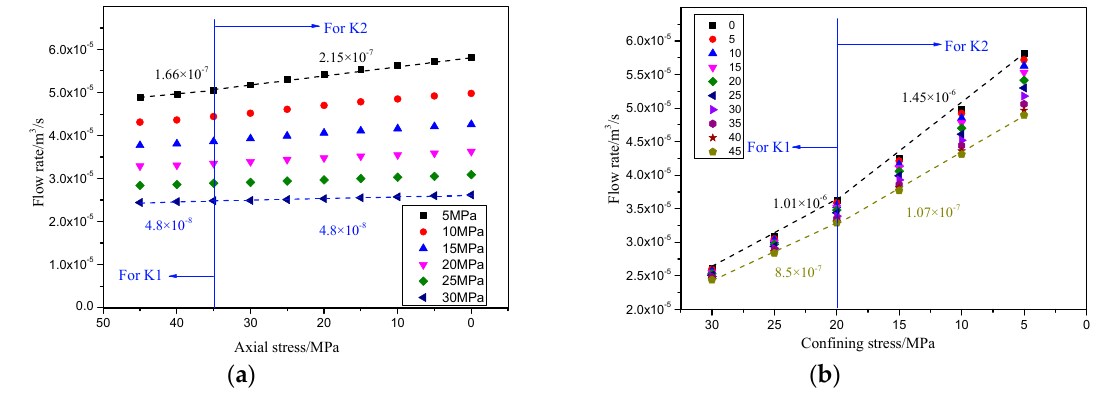
Figure 28. Flow rate change curves of the Y-type crack model: ( a ) variation in flow rate with the axial pressure and ( b ) variation in flow rate with the confining pressure.